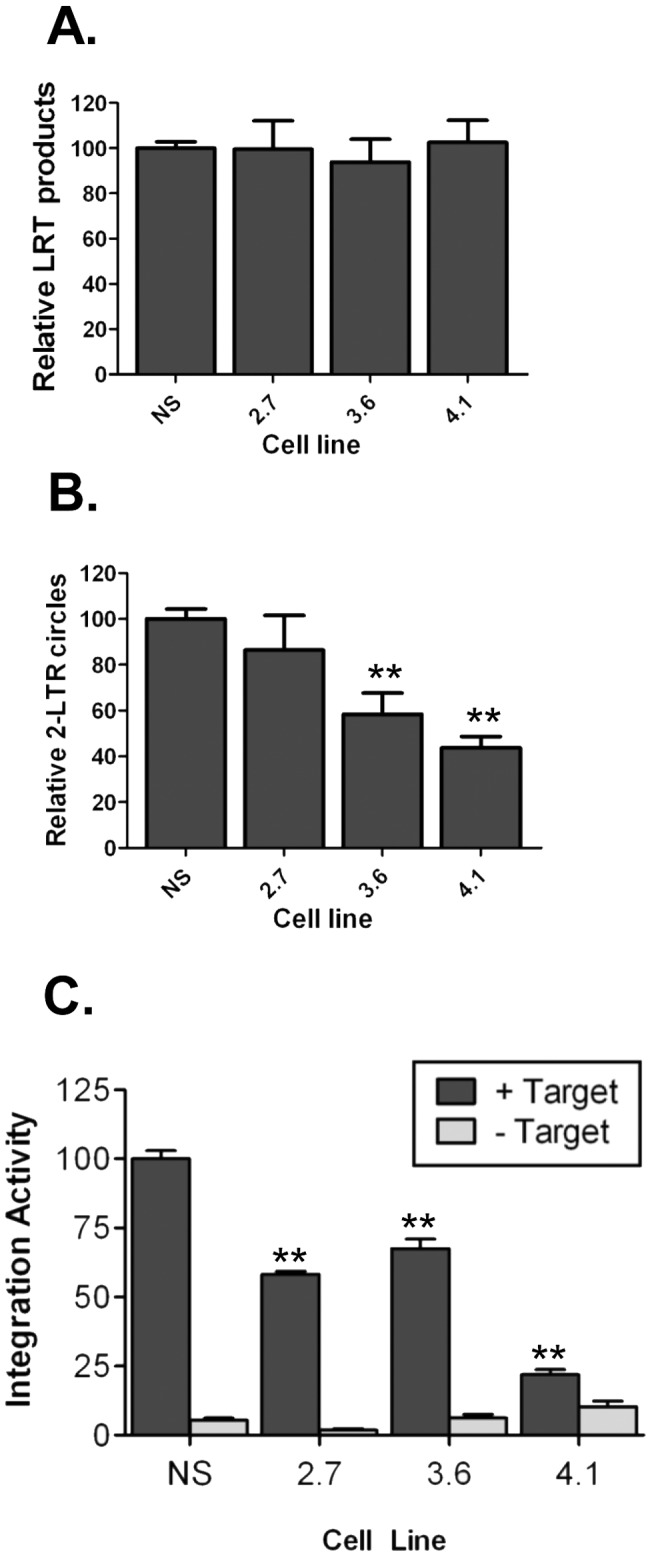
LRPPRC depletion reduces HIV-1 nuclear import and PIC formation.(A) LRT product synthesis in LRPPRC depleted cells. HIV-1 LRT products were measured at 24 hpi by real-time PCR and normalized to the level of mitochondrial DNA in each sample. (B) 2-LTR circle accumulation in LRPPRC cells. 2-LTR circles were quantified by real-time PCR and normalized to the level of late RT product in each sample. Data in panels (A) and (B) are from 3 independent experiments and the error bars denote SEM. ** denotes p<0.01 calculated by two-tailed t-test. (C) PIC activity in shLRPPRC infected cells. In vitro integration activity +/− target DNA was determined for each cytosolic lysate at 6 hpi. Data was normalized to the activity recovered from the NS cells and data combined from three independent experiments. The error bars denote SEM and ** denotes p<0.01 calculated by two-tailed t-test.